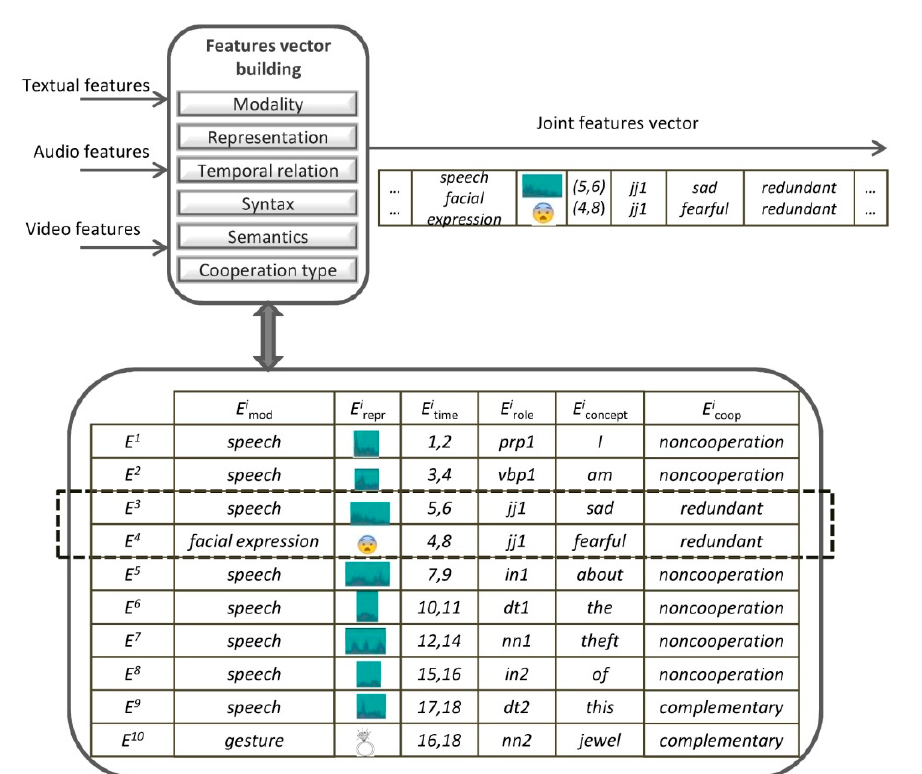
Figure 2. Syntax-graph of the multimodal sentence in Figure 1.